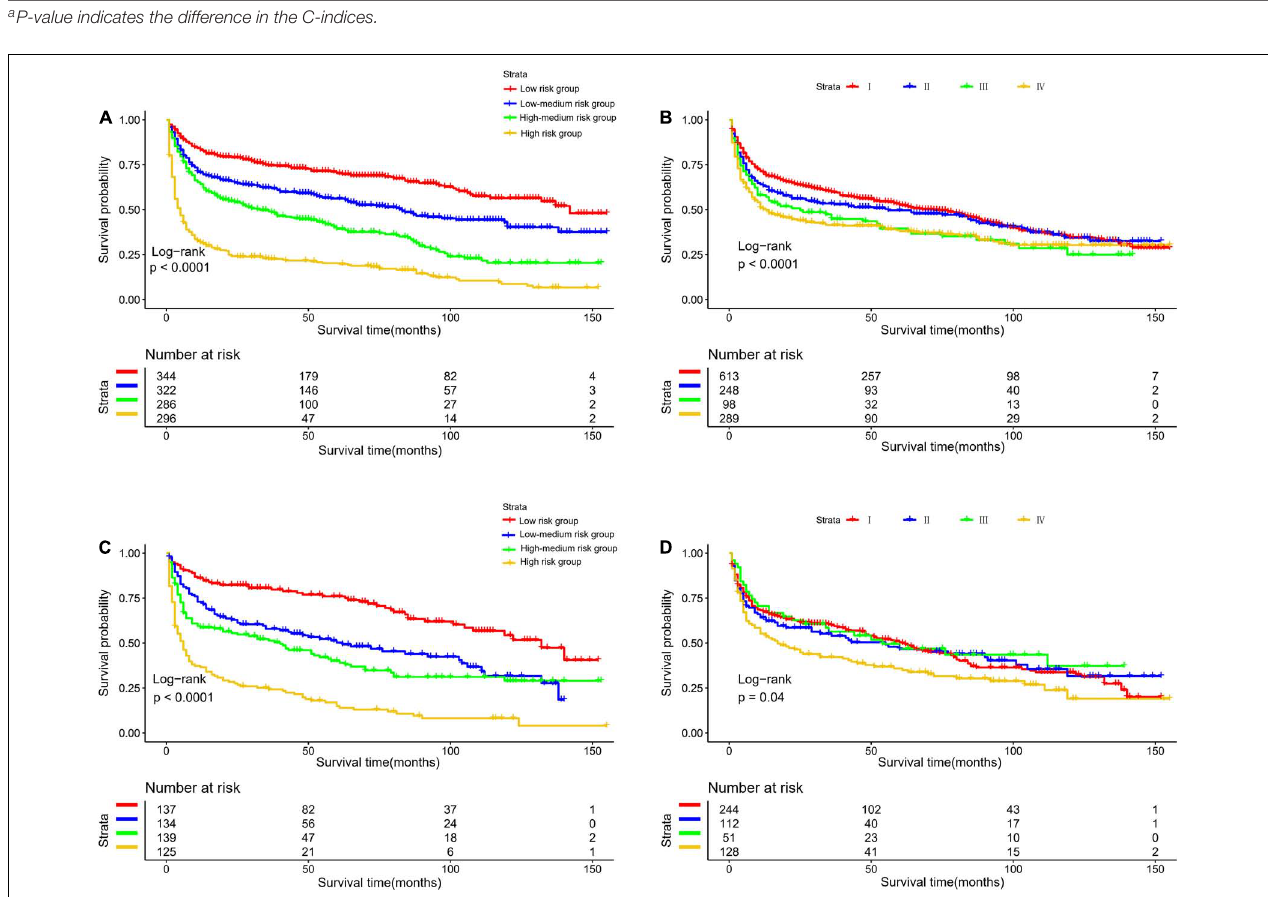
FIGURE 5 | Kaplan-Meier survival curves for risk stratification in the development cohort (A) nomogram (B) stage and validation cohort (C) nomogram (D) stage.